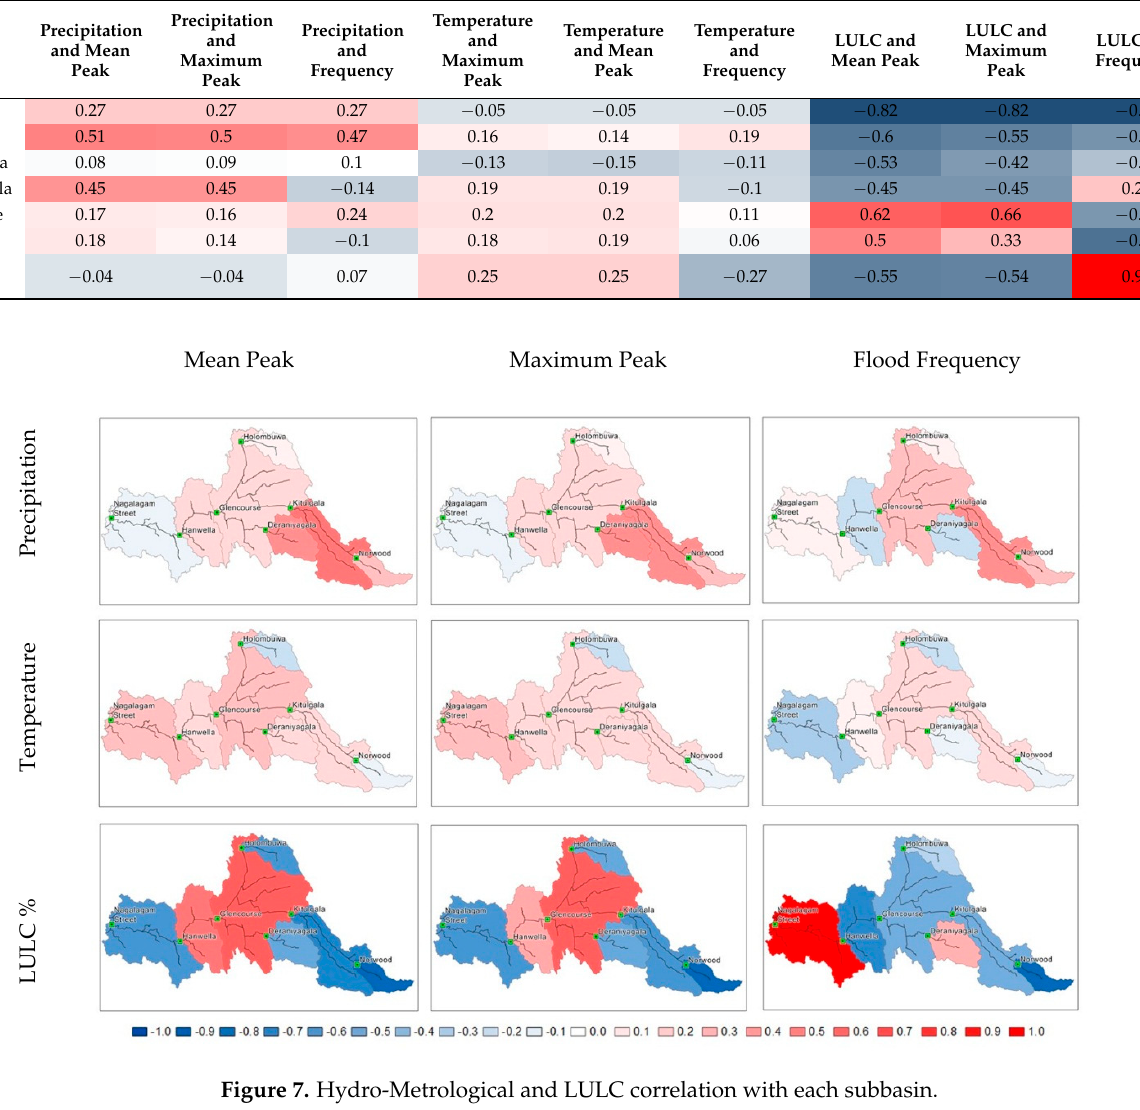
Table 4. Correlation coefficients of climatic factors and LULC for subbasins.